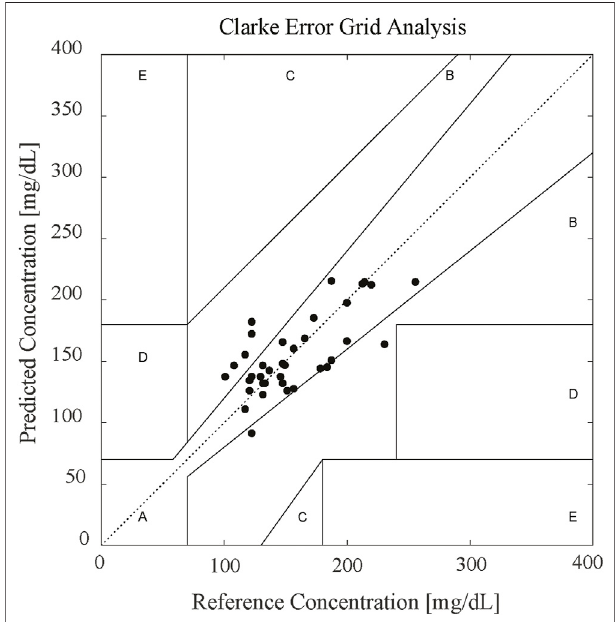
FIGURE 6 | CEG result of 38 in vivo subjects. 78.9% of the estimated bloodglucosevaluesfellinzoneAand100%intheclinicallyacceptablezones A and